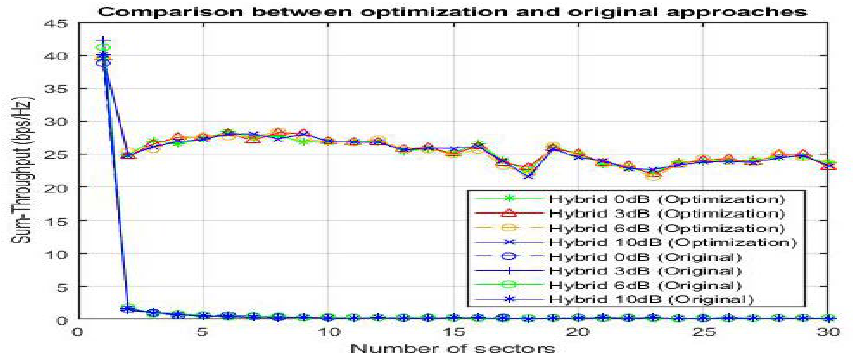
Figure 8. Sum throughput: comparison between optimization and original approaches by SINR